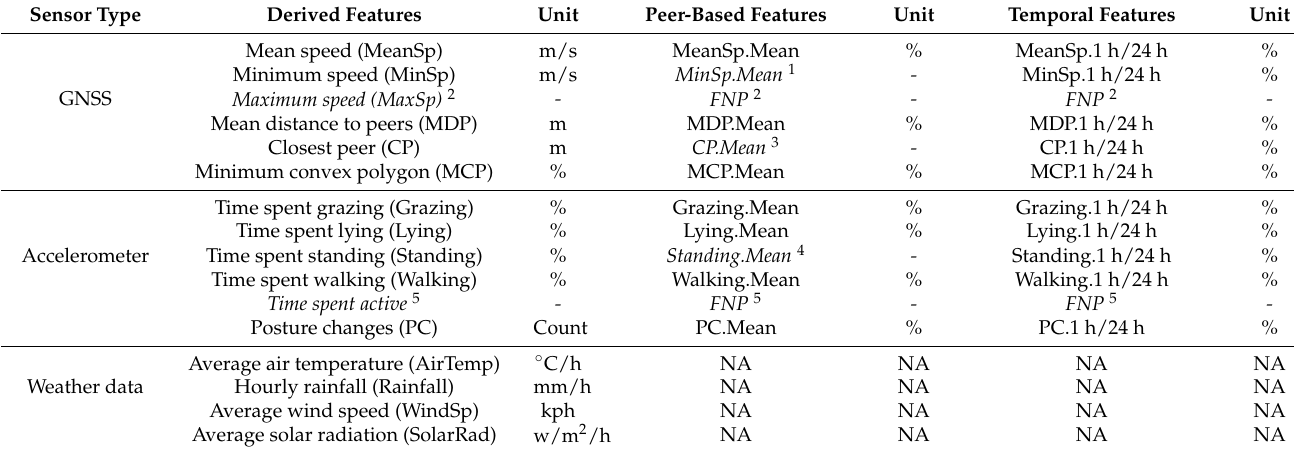
Table 1. Features provided from each sensor type, including the unit of measurement. Derived features are reported as absolute values per hour. Peer-based features are calculated as the percentage difference between the individual ewe and the mean of all other ewes in the flock. Temporal features are calculated as the percentage difference between the current hour and the previous hour (1 h) or 24 h previous (24 h). Features removed due to collinearity are in italics. FNP = Feature not progressed. NA = Not